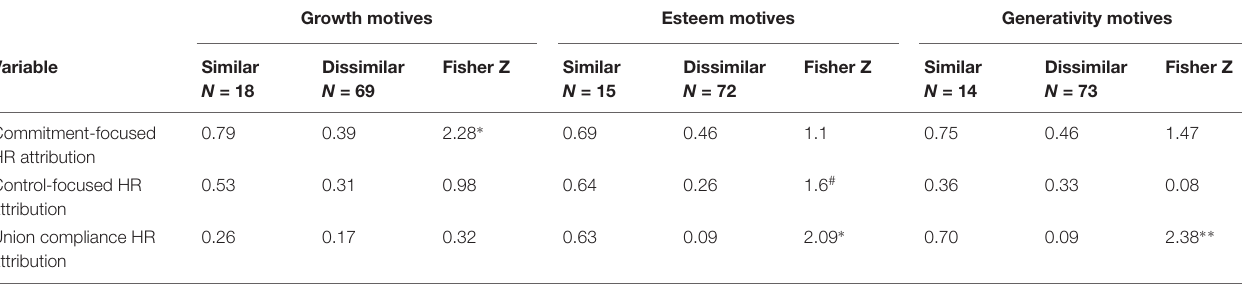
TABLE 3 | Conditional ICC values for similar and dissimilar work motivations to